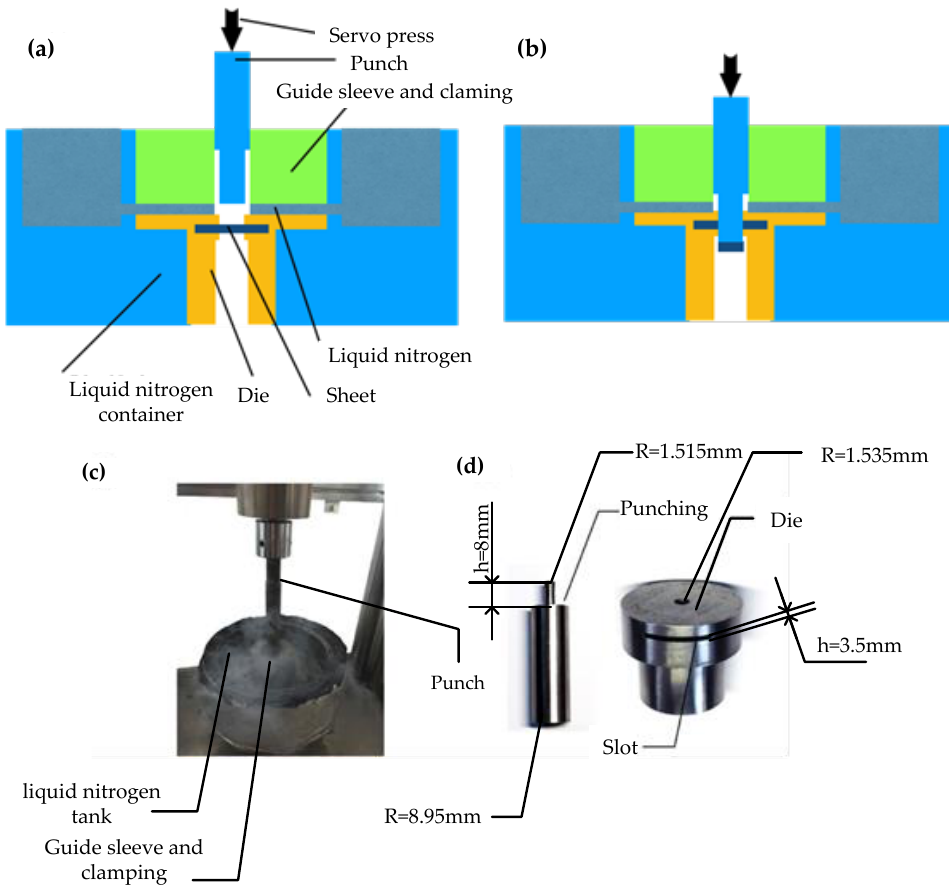
Figure 3. ( a ) Principle of punch shearing; ( b ) the punching process; ( c ) at cryogenic temperature punching; and ( d ) the punch and die. Table 3. Test samples for punch shearing tests.